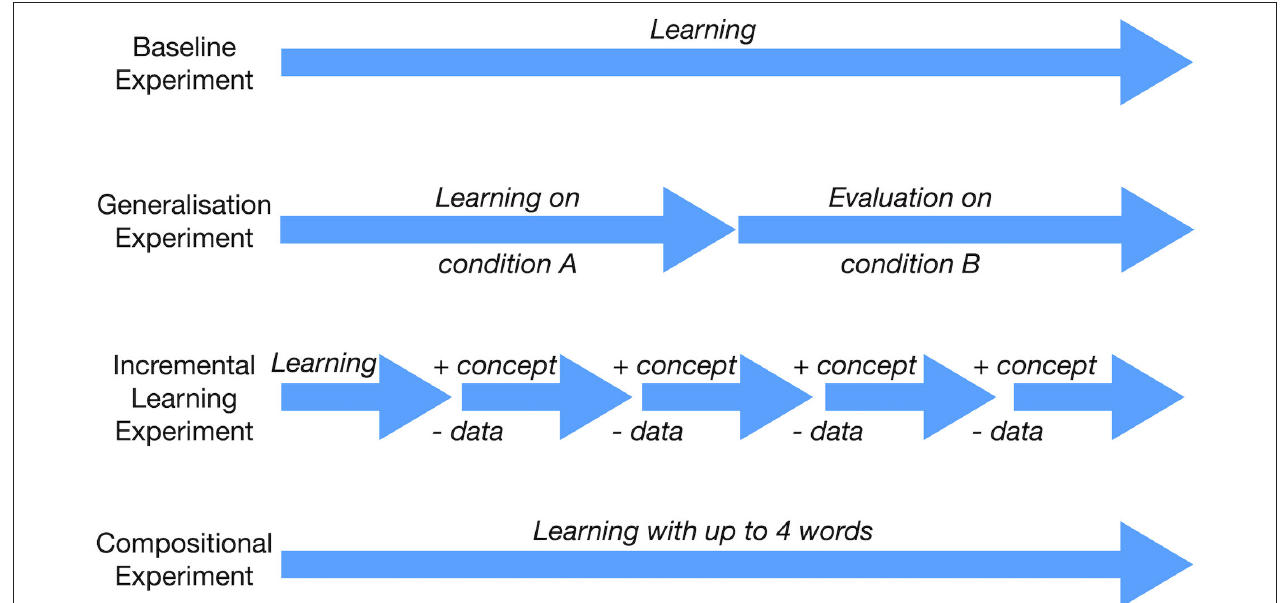
FIGURE 5 | Overview of the experiments, each showcasing a particular aspect of our approach to concept learning.